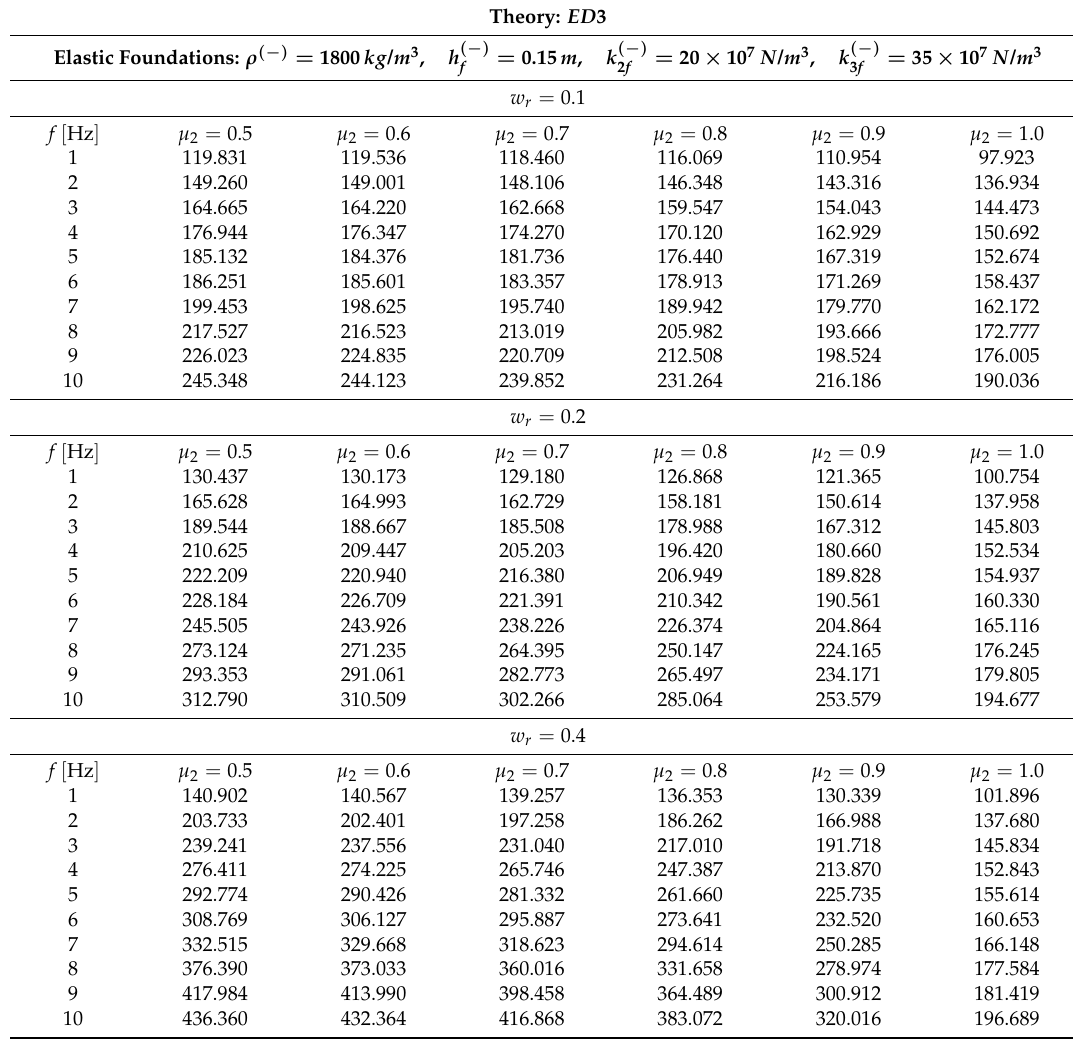
Table 21. First ten natural frequency variations for ED3 theory of a CCFF helicoidal surface (Figure 4c) reinforced by CNTs distributed as in Figure 5c for different mass fractions w r when varying the parameter of agglomeration µ 2 with µ 1 = 0.5. The Chebyshev-Gauss-Lobatto grid distribution was employed, with I N = 31, I M =